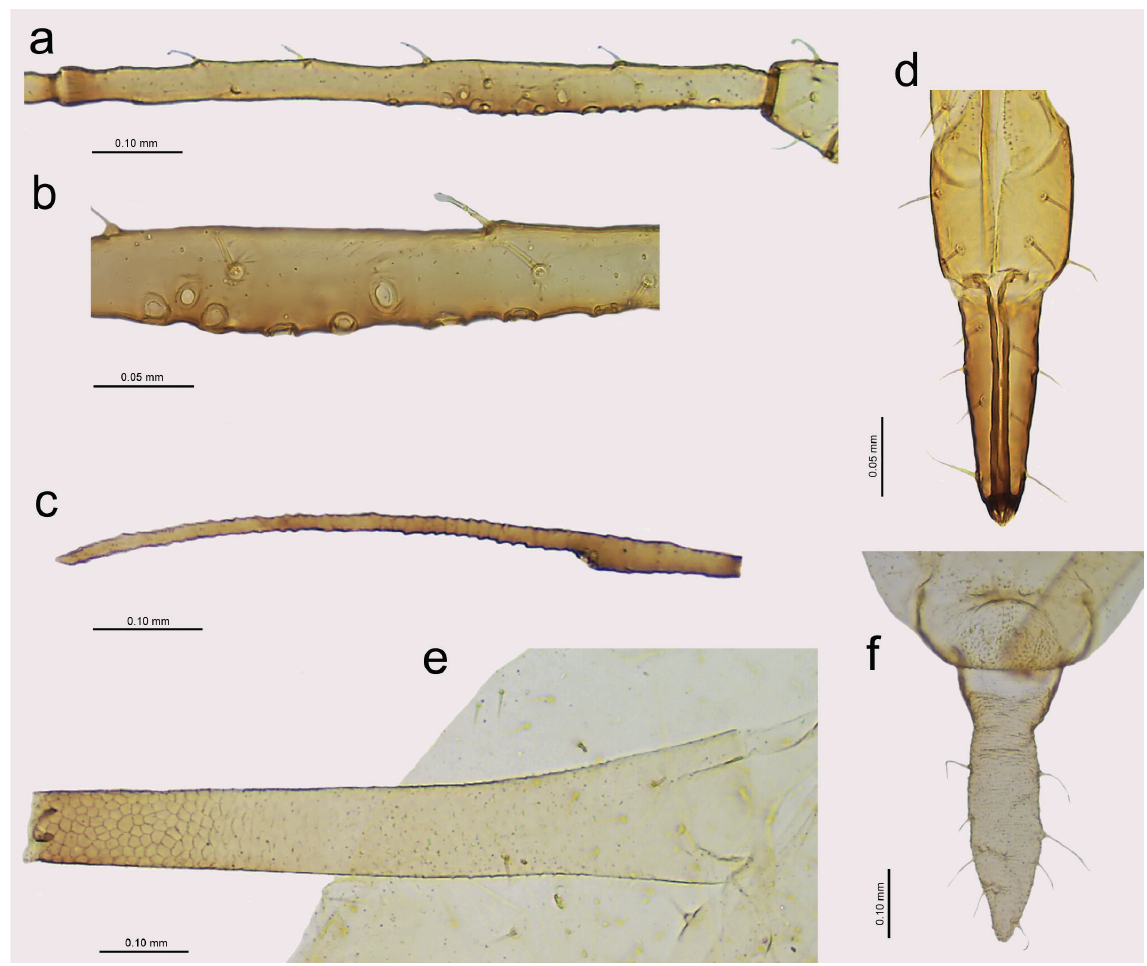
Fig. 3. Uroleucon ( Lambersius ) grindeliae sp. nov., paratype, apterous viviparous female (NHMUK 010121474). a . ANT III. b . Secondary rhinaria on ANT III. c . ANT VI. d . Ultimate rostral (III–V) segments. e . Siphunculus. f .